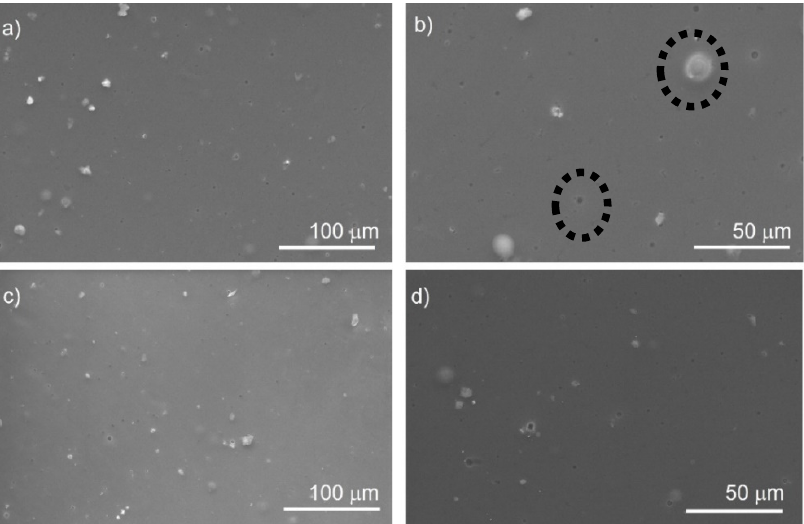
Figure 2. SEM planar-view images of cellulose substrates coated with the two blends. The holes observed in all images are due to imperfections already present in the initial Corapack cellulose film. ( a , b ) SEM images at different magnifications of PVB-PCA obtained by spray coating; ( c , d ) SEM images obtained in different areas of the sample after a spray-coating deposition of PVA-Q. All surfaces are homogeneous with randomly distributed granulates that derive from the imperfect dissolution of the substances in the initial solvent.